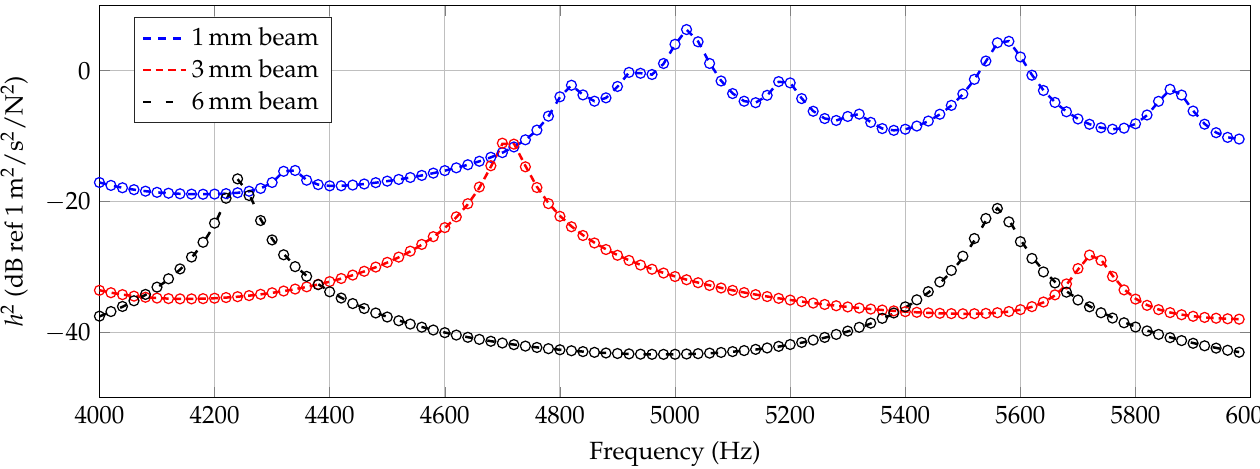
Figure 10. Comparison of h 2 for two elements (dashed line) and three elements (marks) in thickness direction for each